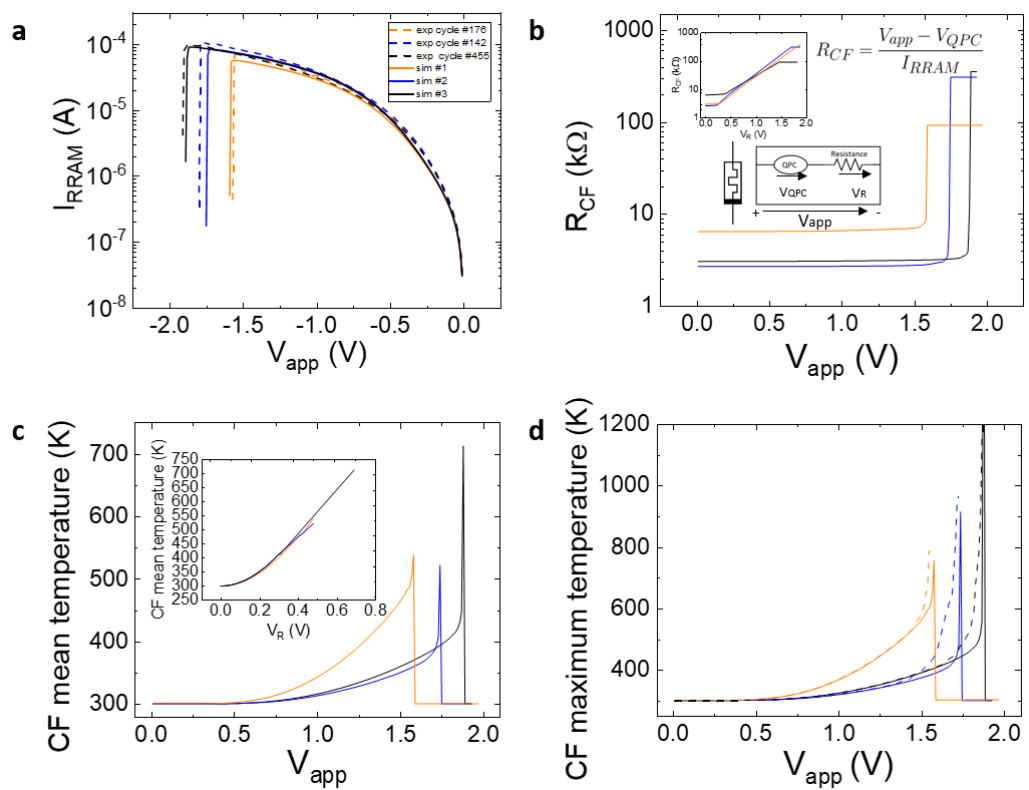
Figure 5. ( a ) Experimental (dashed lines) and simulated (solid lines) I-V curve of the devices under study. Truncated cone CFs of different radii are employed (radii: Sim #1 R t = 0.875 nm, R b =1.75 nm; Sim #2 R t = 1.75 nm, R b =2.25 nm y; Sim #3 R t = 1.50 nm, R b =2.25 nm). ( b ) Ohmic resistance extracted for the simulated reset curve (inset: schema of the model employed and ohmic resistance vs. V R ), ( c ) average CF temperature at each I-V point along the simulated curve (inset: average CF temperature versus V R ), ( d ) simulated CF maximum temperature and the CF temperature (dashed lines) obtained experimentally with a process in line with Ref. [53].